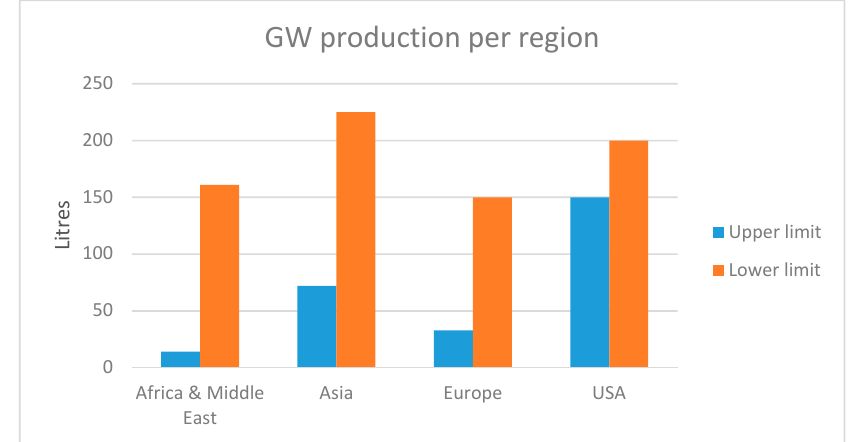
Figure 6. Greywater production per person per day.